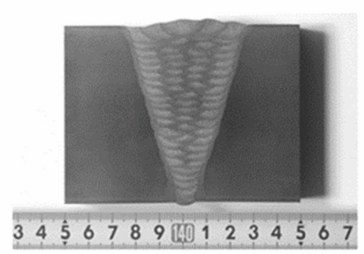
Figure 1. Macro section of thickness 70 mm.